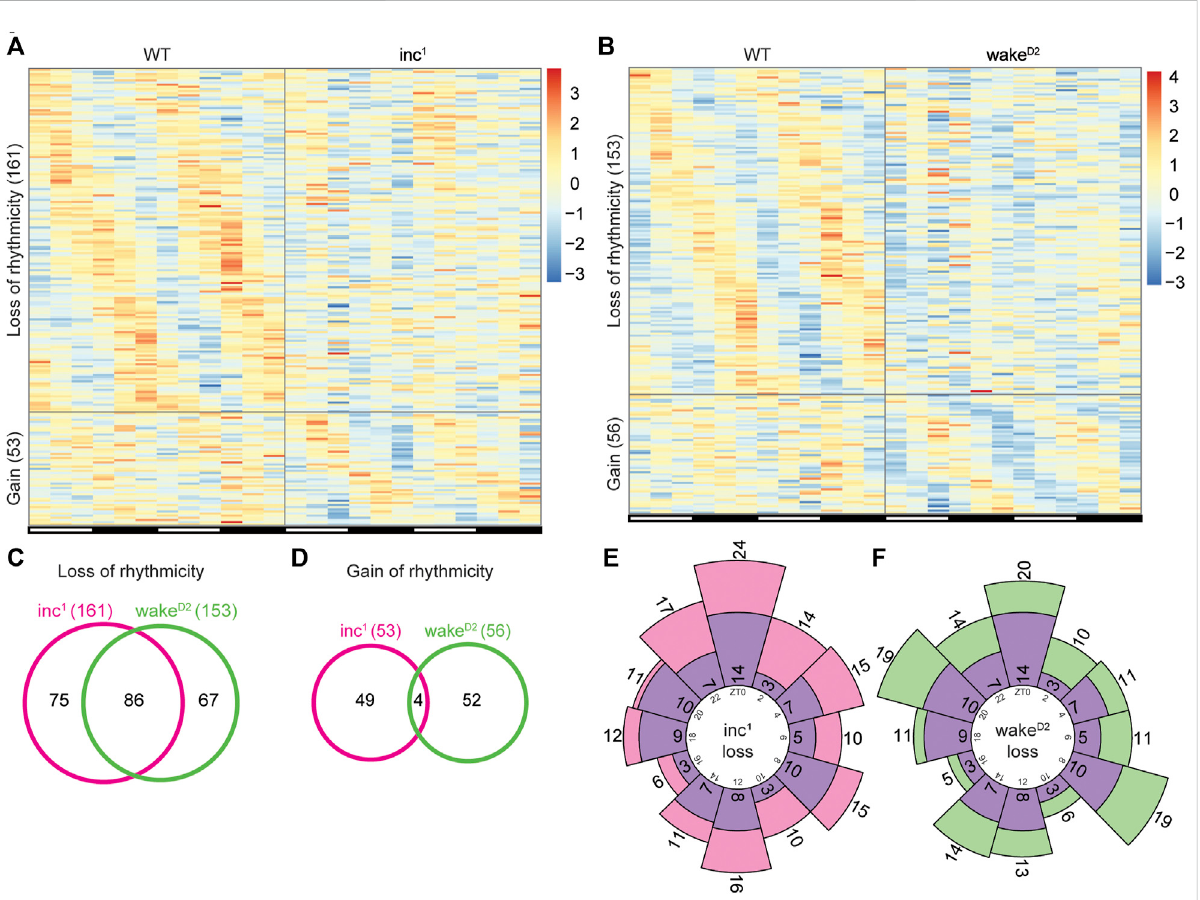
FIGURE 3 Identi fi cationofrhythmicitychangesinchronicallysleepdeprived fl ies. (A,B) Geneswithrhythmicitychangein inc 1 (A) and wake D2 (B) fl ies. “ Loss of rhythmicity ” represents genes that are highly rhythmic in WT and highly arrhythmic in the experimental group, and vice versa for “ Gain ” . Highly rhythmicgenesarede fi nedasBenjamini-Hochbergadjusted p < 0.01andhigharrhythmicgenesasBenjamini-Hochbergadjusted p > 0.5,calculated by JTK cycle. Each row represents one gene, and each column represents one timepoint. Expression levels are normalized to each gene itself and data are aligned according to the peak expressiontime in the highly rhythmicgroup calculated by JTK cycle. The blocked horizontal bars below the panel correspond to the light-dark cycle. (C,D) Intersection of loss of rhythmicity genes (C) and gain of rhythmicity genes (D) in inc 1 (magenta) and wake D2 (green). (E,F) Circular histogram for the distribution of WT peak expression time for loss of rhythmicity genes in inc 1 (E) and wake D2 (F) . Purple bars represent the distribution of WT peak expression time for the 86 intersected genes in (C) . Peak expression times are calculated from the WT samples using JTK cycle. Numbers in the inner circle represent Zeitgeber time (ZT) and numbers in or adjacent to the bars represent number of genes in the corresponding